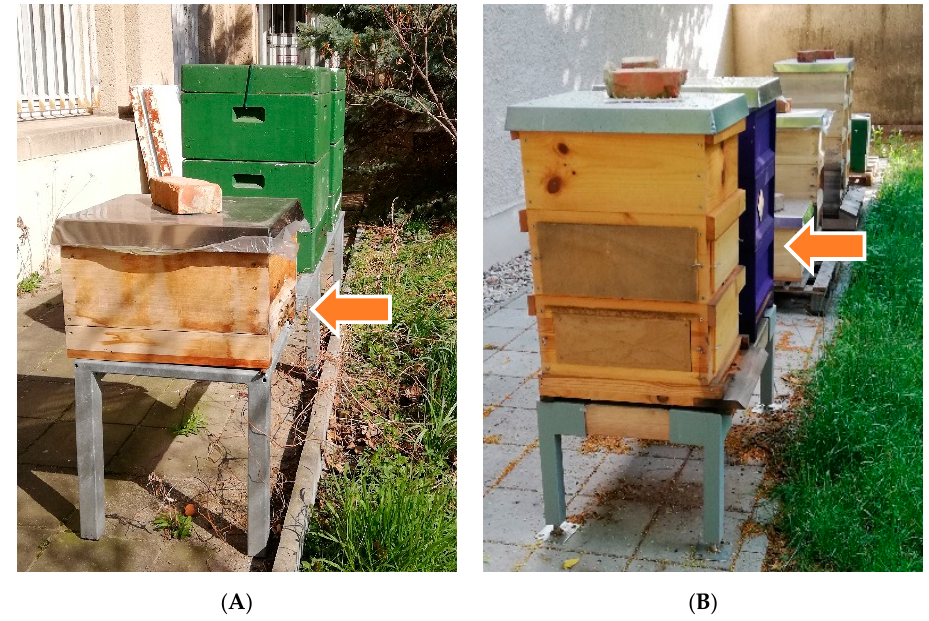
Figure 1. ( A ) Apiary 1 with colony 1 in a wooden Zander hive with one brood chamber in March 2020 (orange arrow), ©Julia Dittes. ( B ) Apiary 2 with colony 2 in a violet painted wooden Zander hive with two brood chambers and one honey super (second in the row) in June 2019 (orange arrow), ©Julia Dittes.